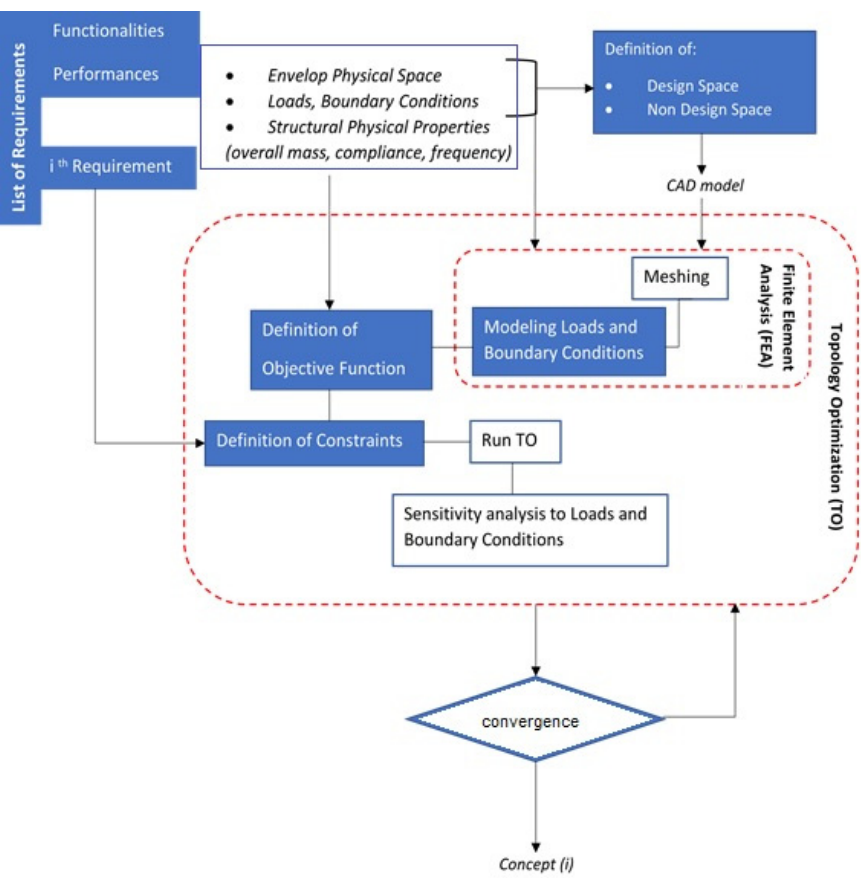
Figure 2. The adopted TO workflow in concept design.